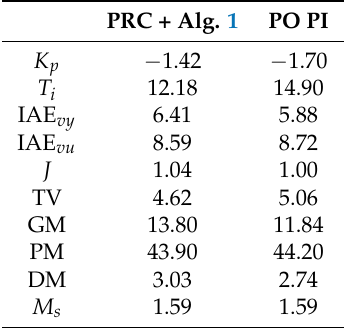
Table 12. Example 5. The corresponding controller parameter, indices and margins are given for prescribed robustness M s =